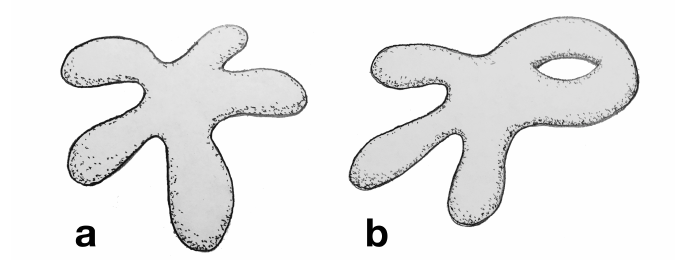
Figure 2. Closed baskets whose surfaces have: ( a ) Zero handles, ( b ) one